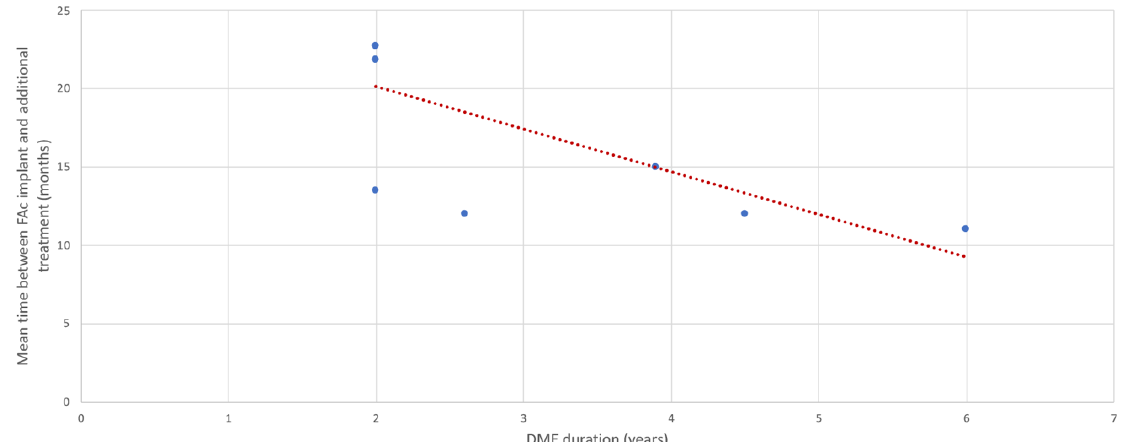
Figure 5. Mean time between fluocinolone acetonide implant and initiation of additional intravitreal DME treatments according to chronicity of diabetic macular edema at the time of injection, in real-world studies evaluating the efficacy of the implant for diabetic macular edema ( n = 6 studies).